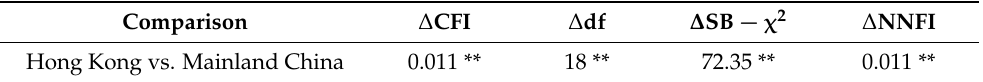
Table 7. Comparisons for cross-regional SEMs between Hong Kong and Mainland China.